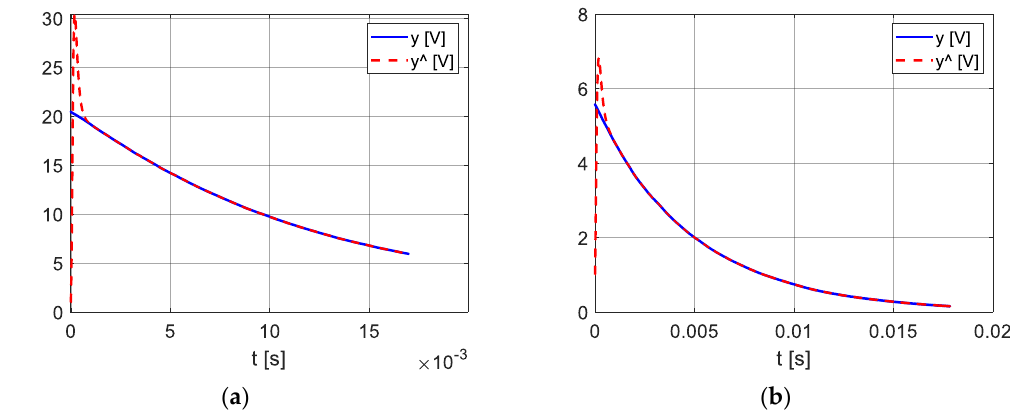
Figure 17. Two-stage discharge of a 470 µ F capacitor. Recording resolution: 200 ns. ( a ) The first discharging stage; ( b ) the second discharging stage.